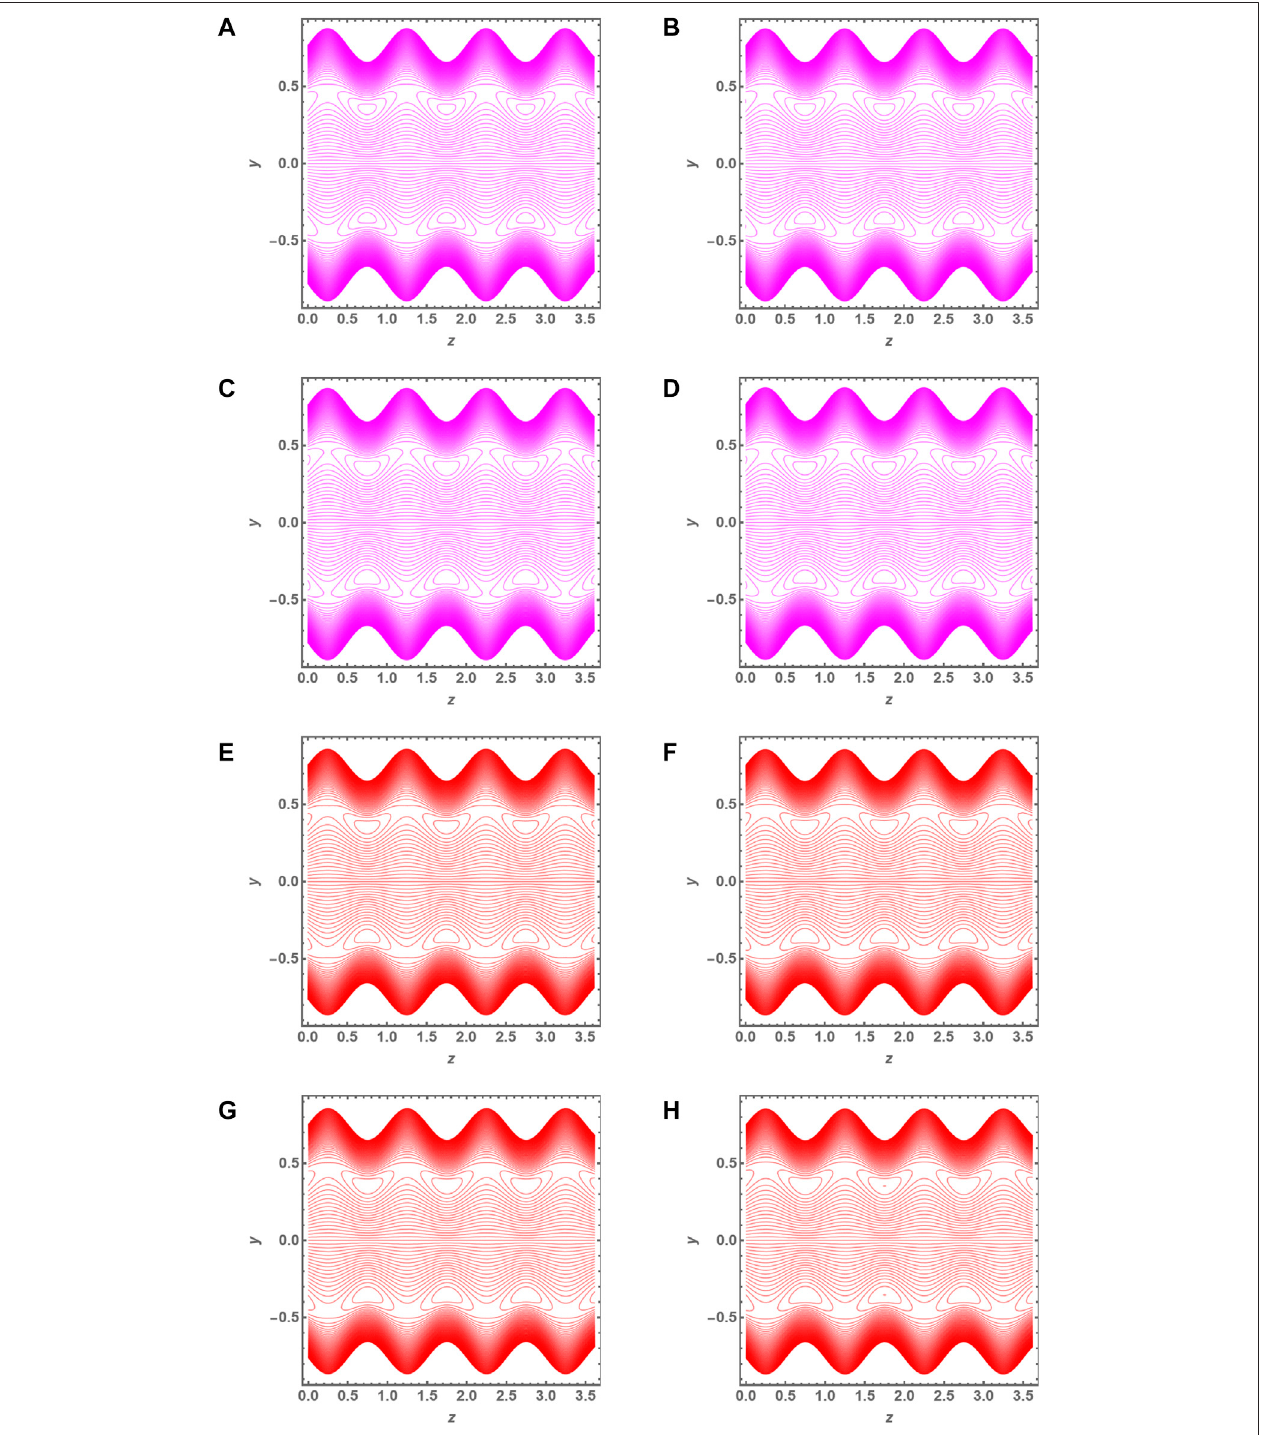
FIGURE 6 | (A) Streamline for Q = 3.26 and α is + ve . (B) Streamline for Q = 3.28 and α is + ve . (C) Streamline for Q = 3.3 and α is + ve . (D) Streamline for Q = 3.32 and α is + ve . (E) Streamline for Q = 3.26 and α is − ve . (F) Streamline for Q = 3.28 and α is − ve . (G) Streamline for Q = 3.3 and α is − ve . (H) Streamline for Q = 3.32 and α is − ve